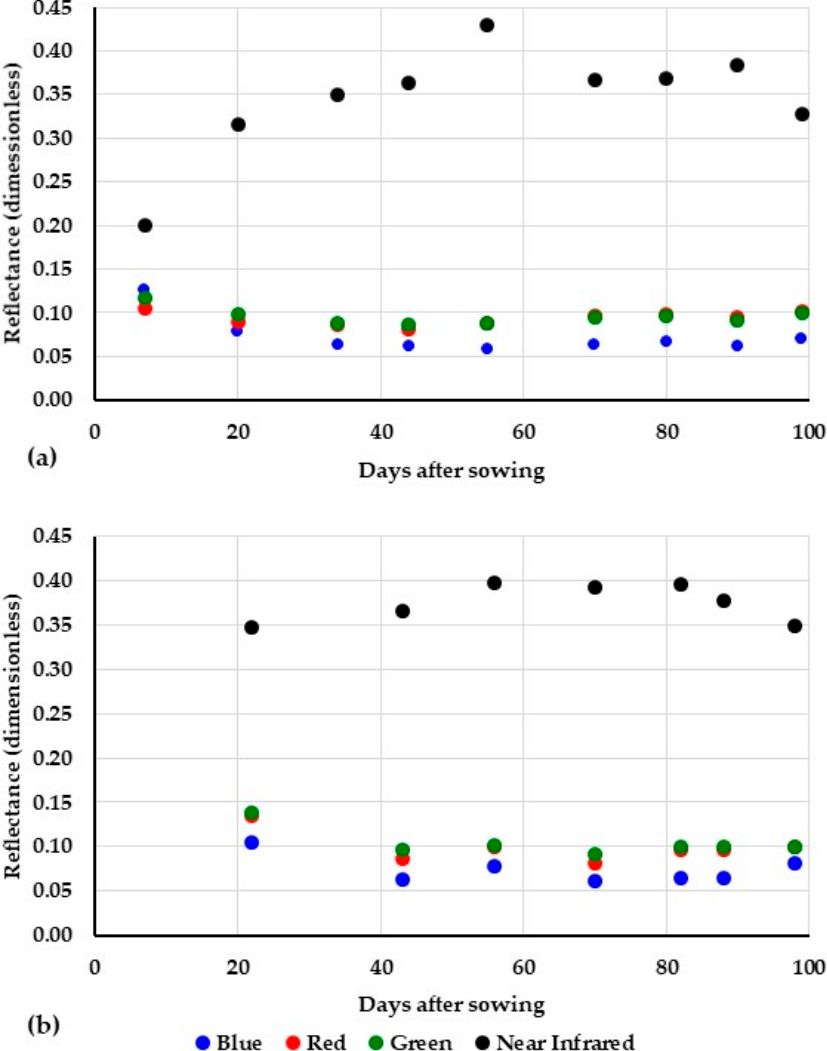
Figure 5. Temporal dynamics of carrot ( a ) and onion ( b ) crop reflectance, scanned by Sentinel-2A throughout the growth period.